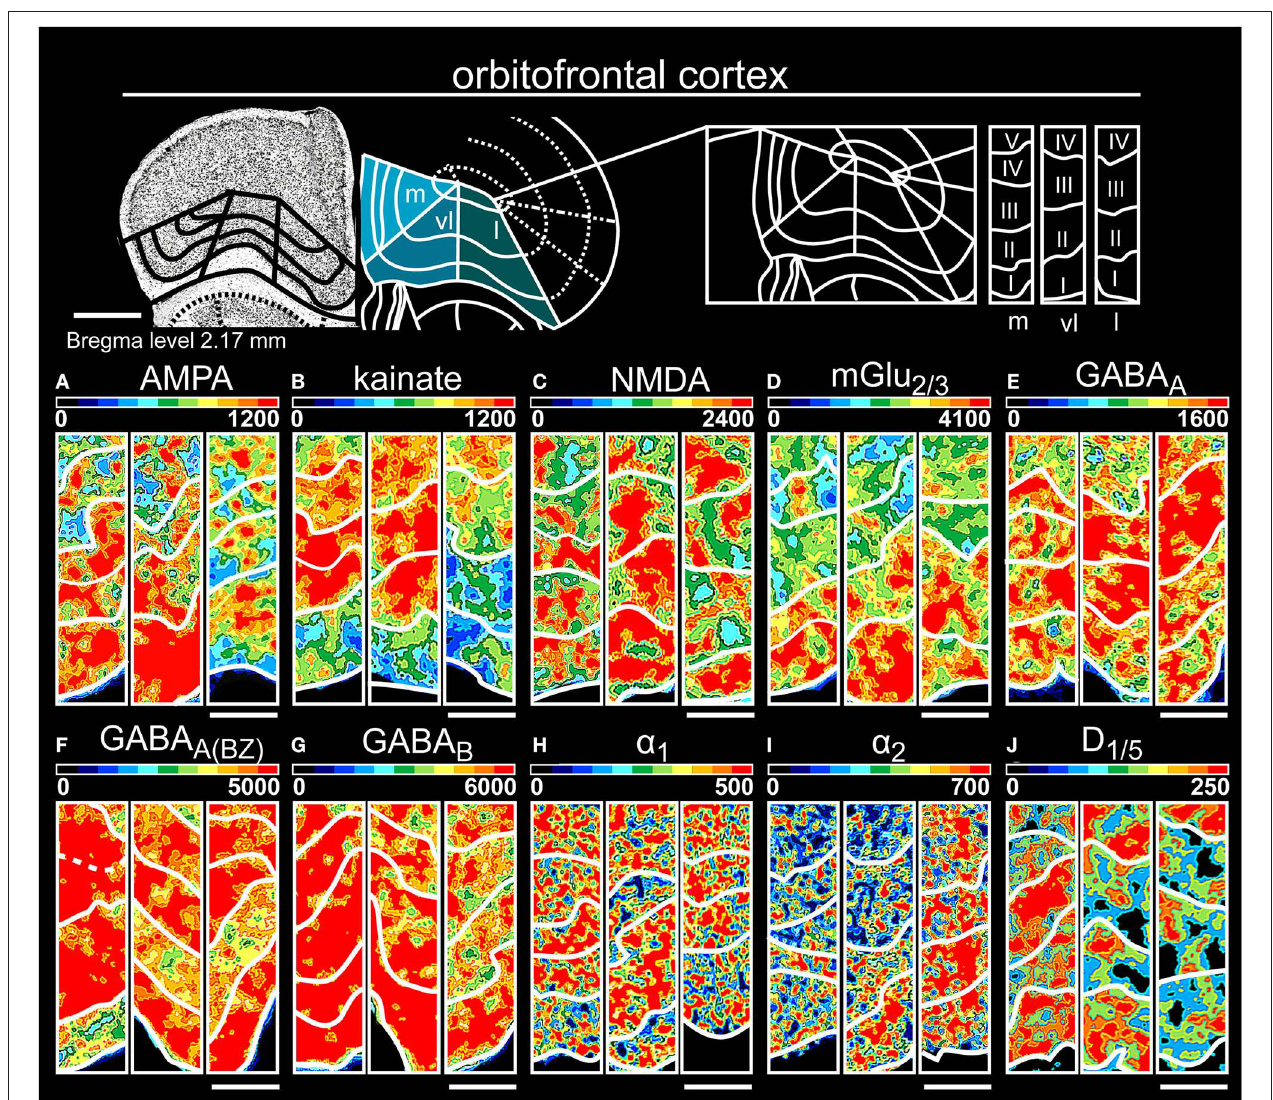
FIGURE 9 | Color-coded autoradiographs showing the distribution and density of all investigated receptors of the orbitofrontal cortex ( l , lateral; m , medial; vl , ventrolateral). Densities of the color-coded autoradiograms in fmol/mg protein according to color scales. For detailed receptor densities see Table 1 . Scale bars: Atlas, 800 µ m; (A–J) , 300 µ m. I, layer 1; II, layer 2; III, layer 3; IV, layer 4; V, layer 5; VI, layer